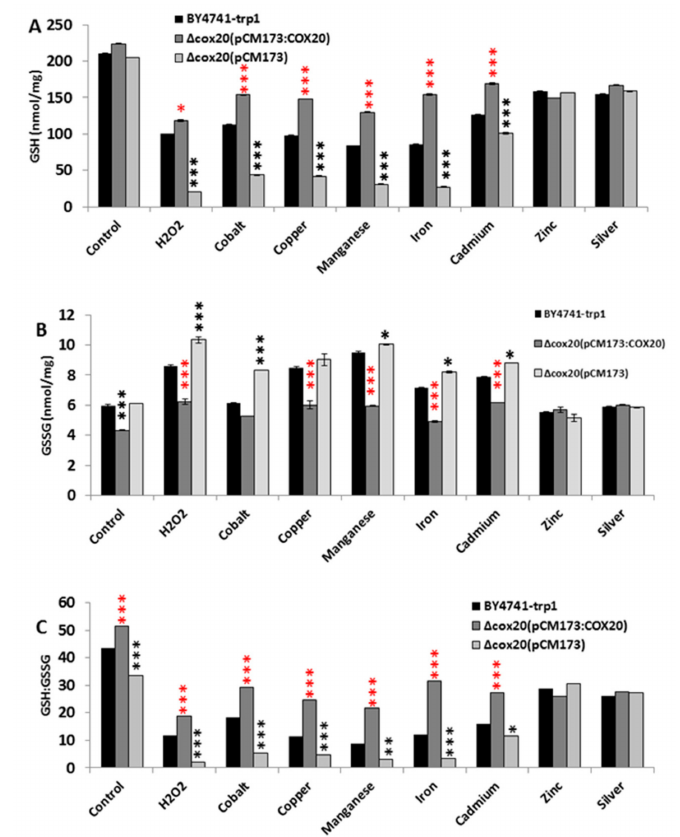
Figure 4. Overexpression of COX20 reduced the presence of oxidized glutathione in BY4741- trp1 , ∆ cox20 (pCM173), and ∆ cox20 (pCM173: COX20 ) yeast cells ( A ) reduced GSH levels in control, 1 mM hydrogen peroxide, and 0.5 mM CuSO 4 , FeSO 4 , MnSO 4 , CdSO 4 , CoSO 4 , ZnSO 4 , and AgSO 4 , respectively, ( B ) oxidized GSH (GSSG) levels in control, hydrogen peroxide, and CuSO 4 , FeSO 4